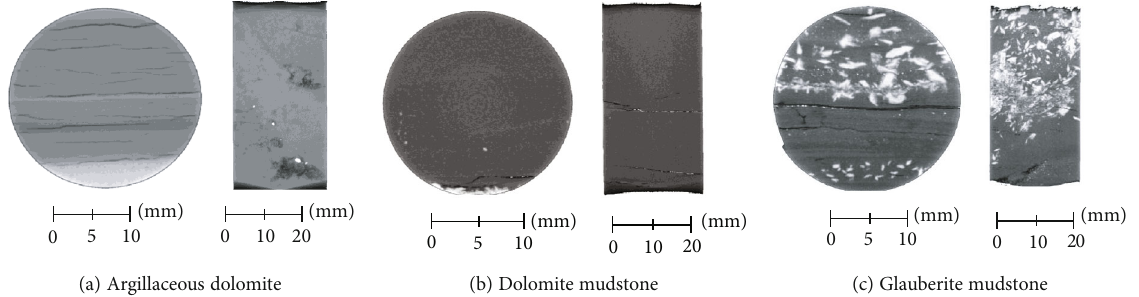
Figure 4: Micro-CT scanning results of the core rock (white spots are salt particles).